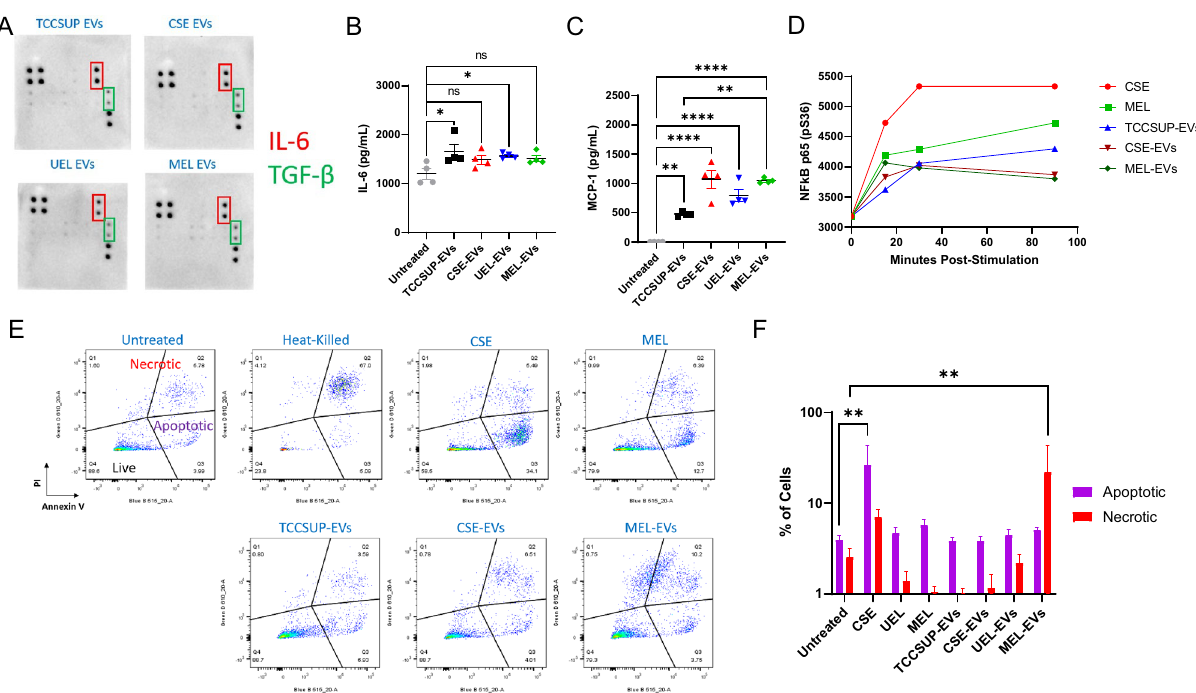
Figure 2. Smoking- and E-liquid-induced BCEVs provoke inflammatory responses. ( A ) Cytokine content in the indicated BCEV samples was detected using a semi-quantitative cytokine array. EVs were dissociated using 1% Triton X-100. Spots in the upper right and lower left corners are positive controls. ( B,C ) The release of IL-6 ( B ) and MCP-1 ( C ) from SV-HUC cells treated for 24 h with the indicated BCEVs (40 µg/mL) was detected using a Legendplex 13-Plex human inflammation kit by flow cytometry. ( D ) NF-κB phosphorylation was measured by flow cytometry over time in cells treated with the indicated stimuli over time. ( E,F ) The relative induction of apoptosis and necrosis in SV-HUC cells treated with the indicated BCEVs (40 µg/mL) was detected by flow cytometry using an Annexin-V/PI staining kit. Heat-killed cells were included as a positive control. All results are representative of a minimum of three experiments. Data are means ± SEM. ns not significant, *P < 0.05, **P < 0.01, ***P < 0.001, ****P < 0.0001; one-way ANOVAs with Tukey’s post hoc test ( B,C ) or two-way ANOVAs with Dunnett’s multiple comparisons test ( F